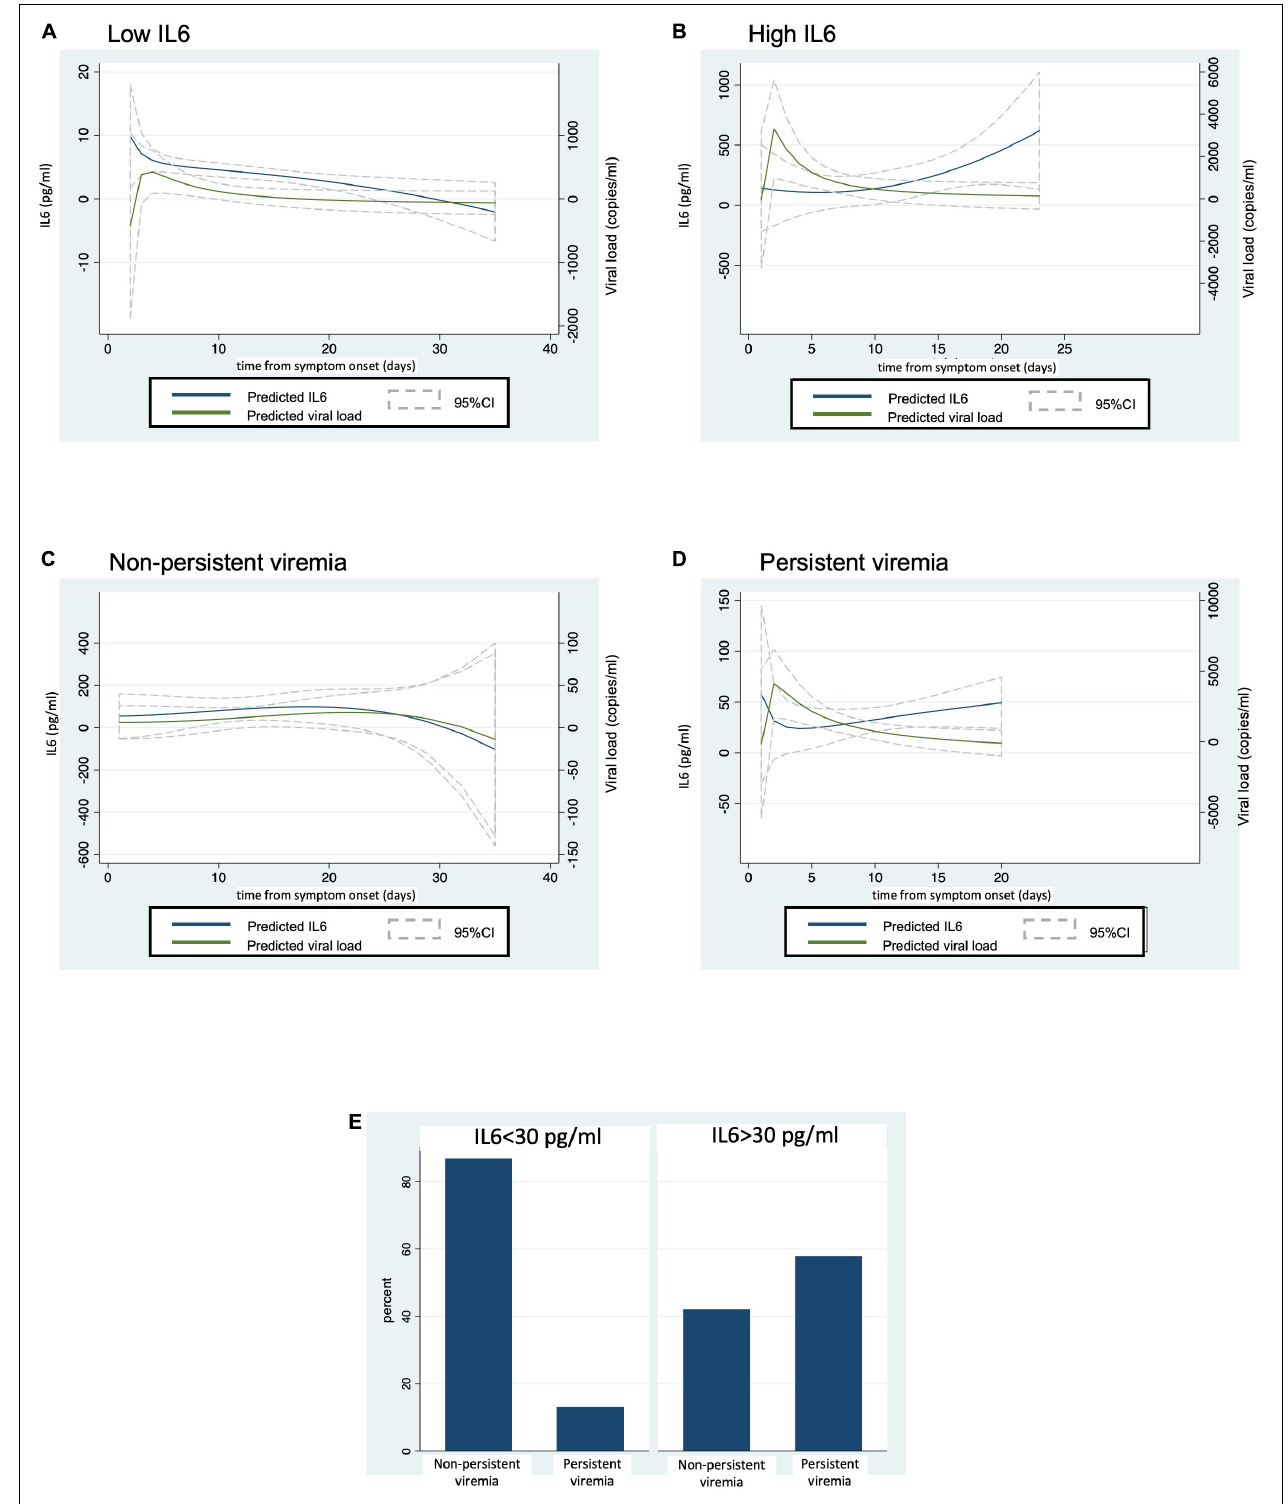
FIGURE 2 | Patients with worse outcomes have an early peak of SARS-CoV-2 viral load before a prominent increase in IL6 levels. Graphic representation of IL6 levels and SARS-CoV-2 viral load from symptom onset in: (A) patients with low IL6; (B) patients with at least one IL6 > 30 pg/ml (high IL6); (C) non-persistent viremia; and (D) persistent viremia. (E) Represents the percentage of patients with persistent viremia according to IL6 levels (low vs. high). (A–D) The fractional polynomial predictions were performed using the twoway command of Stata.